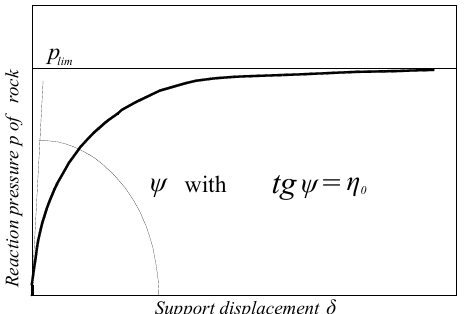
Figure 2. Reaction pressure p of rock mass and support deformation δ of lining.